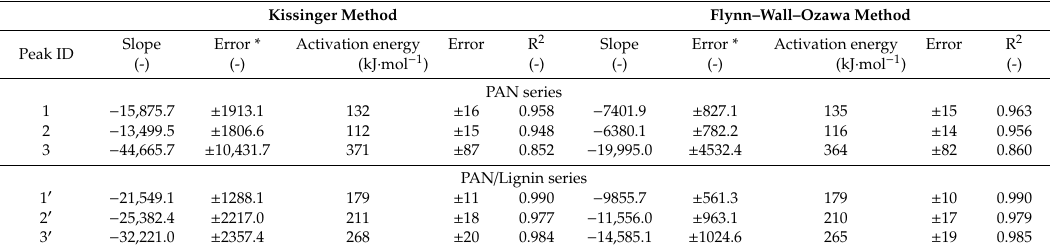
Table 5. Activation energy of di ff erent degradation peaks of neat PAN fibers and PAN / lignin fibers under nitrogen atmosphere calculated from the Costs–Redfern method and the Flynn–Wall–Ozawa method; * error of the linear regression. For more details about the peak ID assignments, please refer to Supplementary Data Figure S3. Kissinger